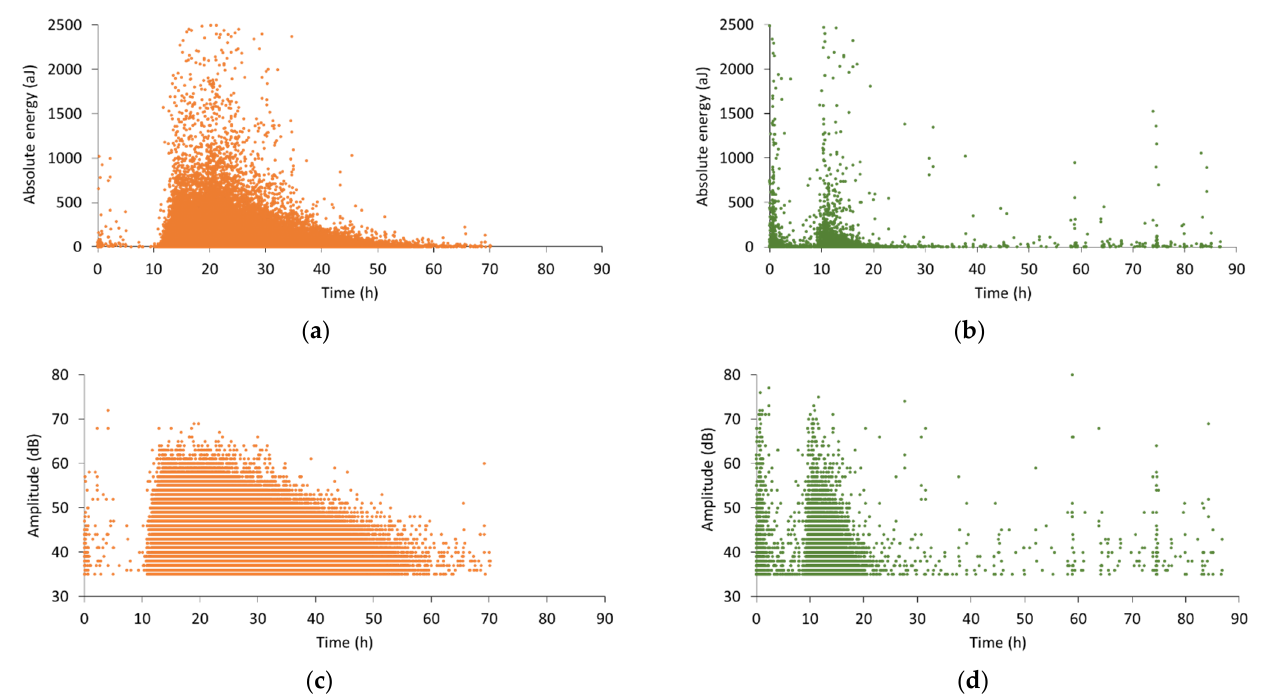
Figure 7. Wave parameter analysis: absolute energy of ( a ) SAP and ( b ) LWA mortar compared to amplitude of ( c ) SAP and ( d ) LWA mortar.